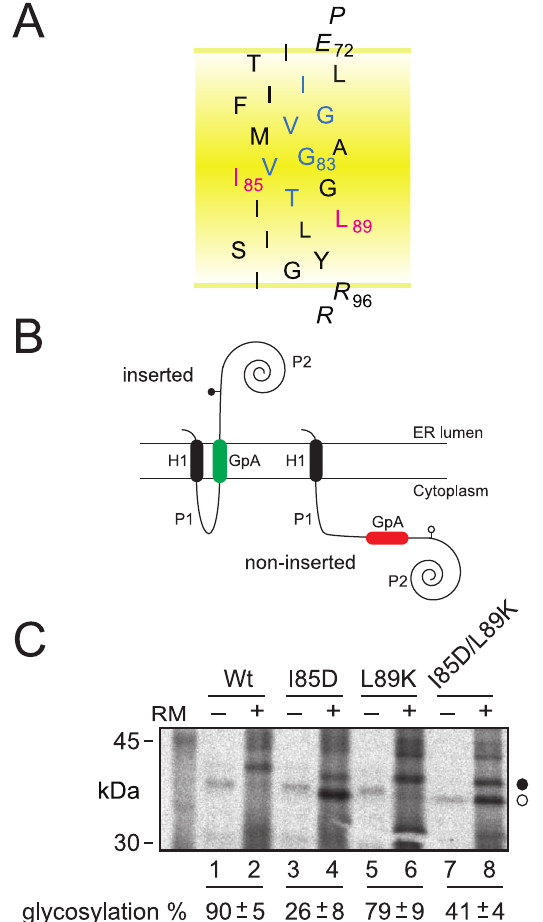
Figure 4. Insertion of GpA-derived segments into microsomal membranes. (A) Model of the GpA TM wild-type sequence. GpA residues involved in dimer formation are blue, the hydrophobic residues replaced to ionizable residues are magenta, and flanking residues are shown in italic. (B) Membrane topology of Lep chimeras. The second TM segment of Lep was replaced by the GpA TM amino acid sequence (gray). The glycosylation acceptor site located in the beginning of the P2 domain will be modified only if GpA-derived TM sequence inserts into the membrane. (C) In vitro translation in the presence of rough microsomal membranes (RM). Proper insertion of the GpA-derived TM sequences results in an increase in molecular mass of about 2.5 kDa relative to the observed molecular mass of the proteins expressed in the absence of microsomes. Bands of nonglycosylated and glycosylated proteins are indicated by white and black dots, respectively. Average 6 s.d. of glycosylation results from four independent experiments are shown at the